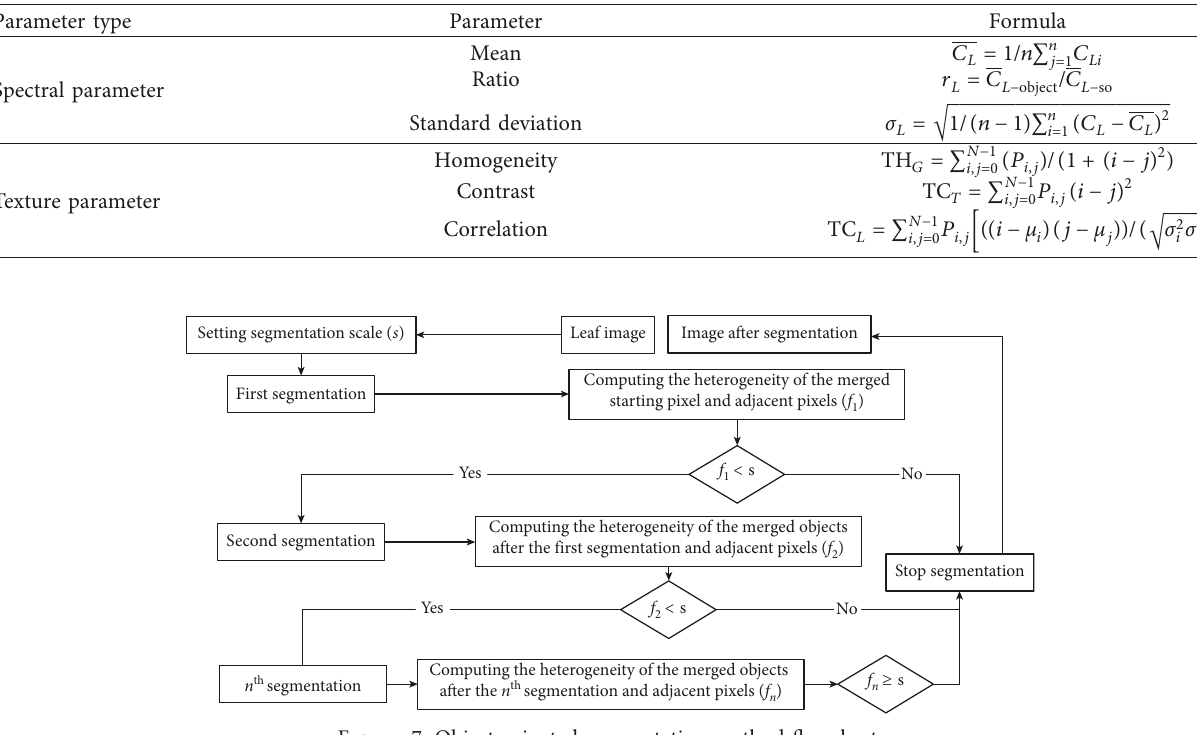
Figure 7: Object-oriented segmentation method flowchart. Table 3: Characteristic parameters from scanning images under K